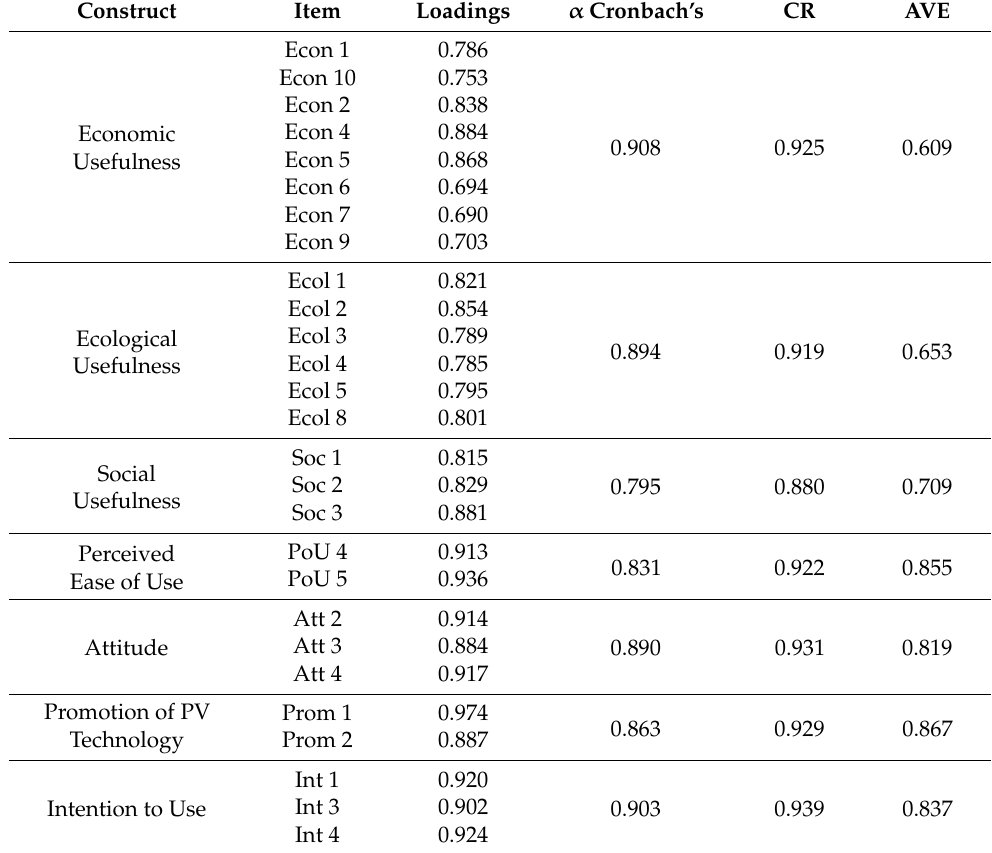
Table 2. Indicator reliability, convergent reliability, internal consistency.